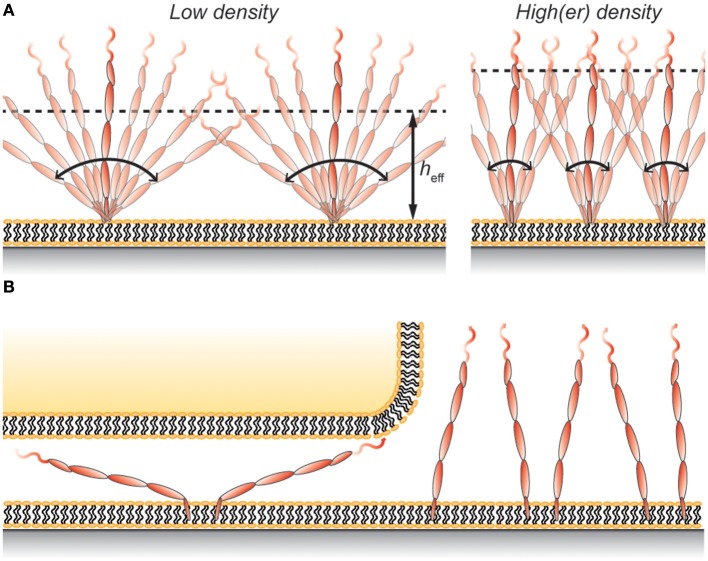
(A) Protein rotation gives rise to an effective height, heff, that is lower than the full length of the protein. The value of heff depends, in addition to the properties of the protein, also on the protein density on the membrane. (B) Rotating membrane-anchored proteins can fit in gaps smaller than the length of the protein even without deforming the membrane. However, this restricts the possible angles the protein can have and comes at a cost in entropy, which leads to protein exclusion at the contact.